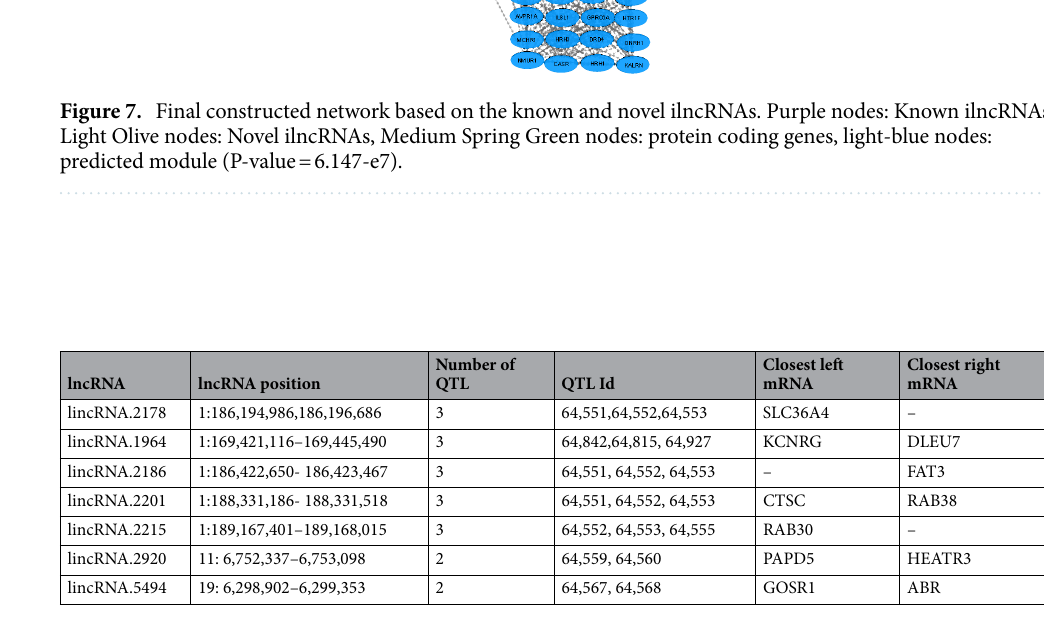
Table 3. The list of identified novel lincRNAs in more than one QTL related to feed